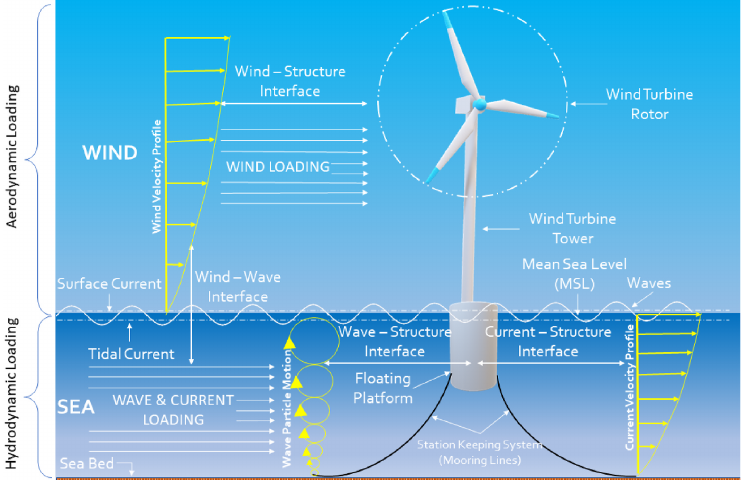
Figure 6. Schematic diagram of fluid-structure interfaces and dynamic loads experienced by a FOWT [71].